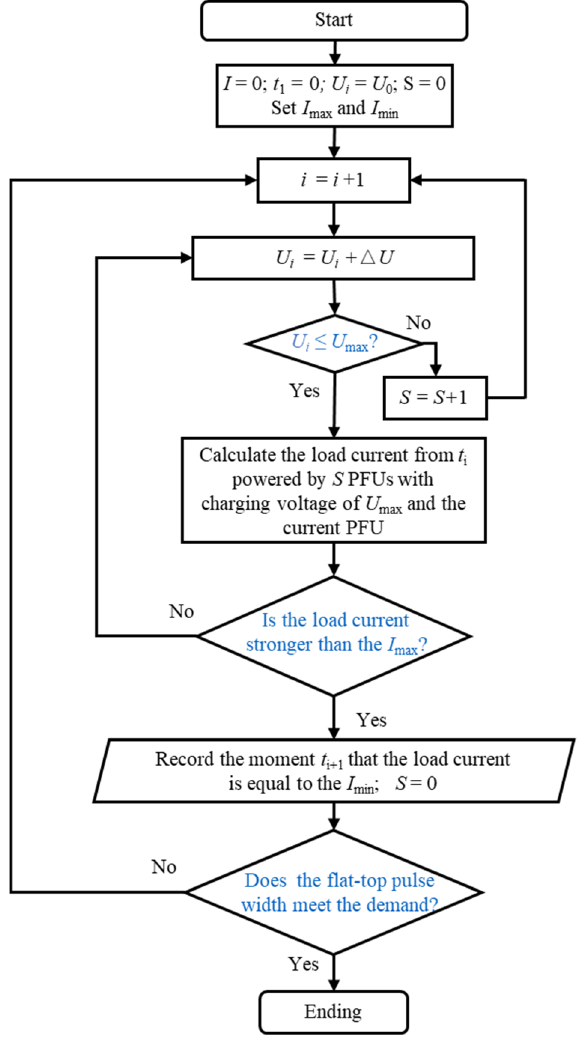
Figure 6. The flow chart of the control strategy.